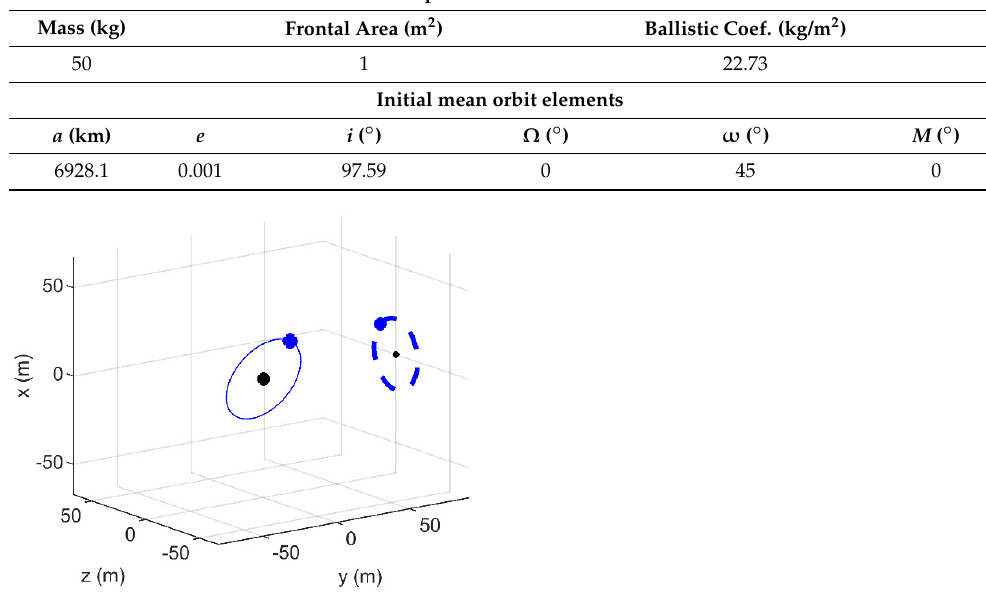
Figure 1. Spacecraft formation based on safety tubes as seen in the Hill reference frame of the chief satellite ( black dot ). The deputy ( blue dot ) is arranged to orbit around the chief so that its radial/cross-track baseline (dashed trajectories in the xz plane) encompasses a safety tube of radii equal to 20 m.